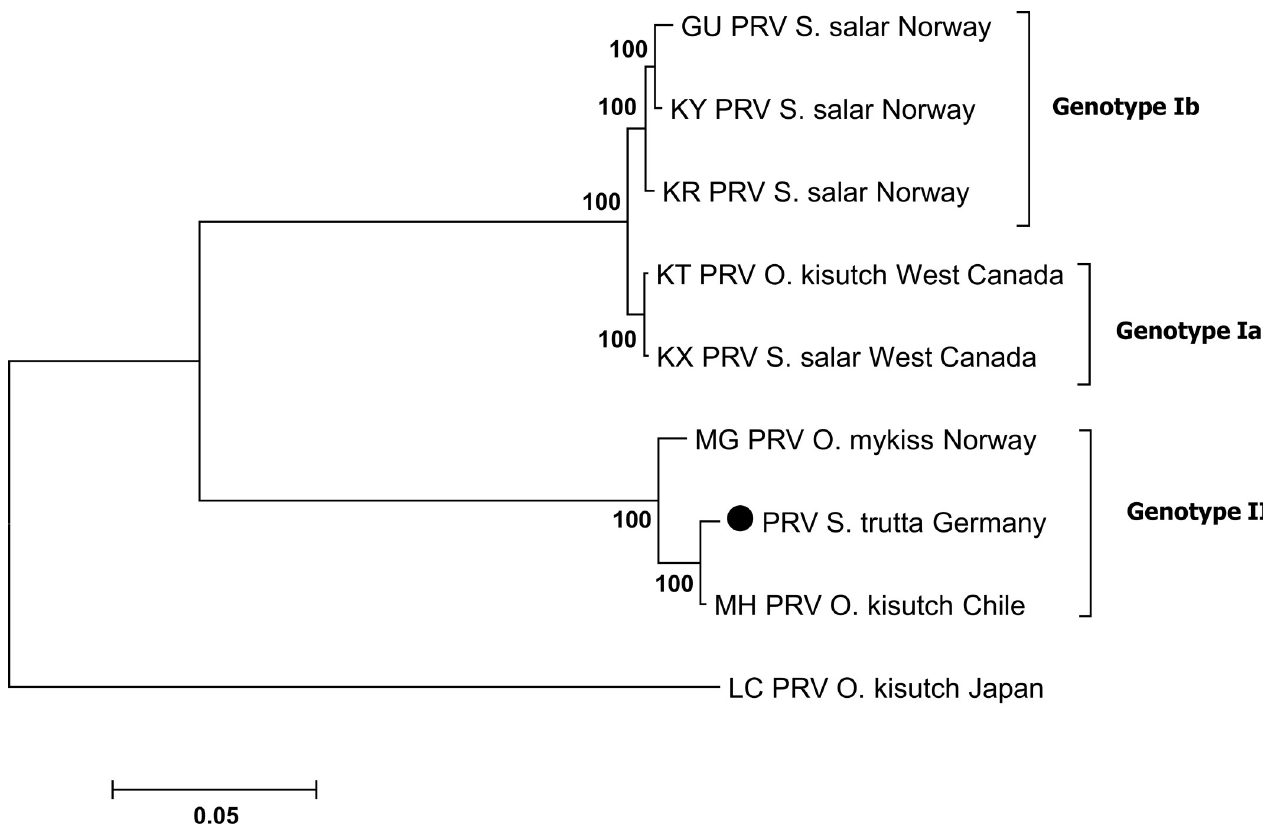
Fig 2. Phylogenetic analysis based on 51.0% of the genome sequence of the novel virus ( λ 1, λ 2, λ 3, μ 2, μ 1, μ NS, σ 3, σ 2, σ NS and σ 1) and sequences of the piscine reovirus downloaded from the NCBI database. The scale bar (left below) refers to substitutions per amino acid sites. Numbers on the nodes represent the confidence limits ( > 50%) estimated from 100 bootstrap replicates. The cluster definition (Genotype Ia, Ib, and II) is displayed according to Takano et al. [40]. The sequence of this study is symbolized by a solid circle.